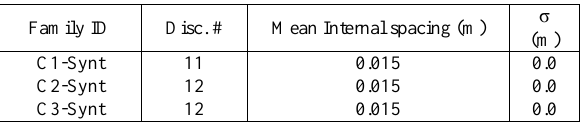
Table 7. Results for the internal characterization of the corridor of F2-Synt